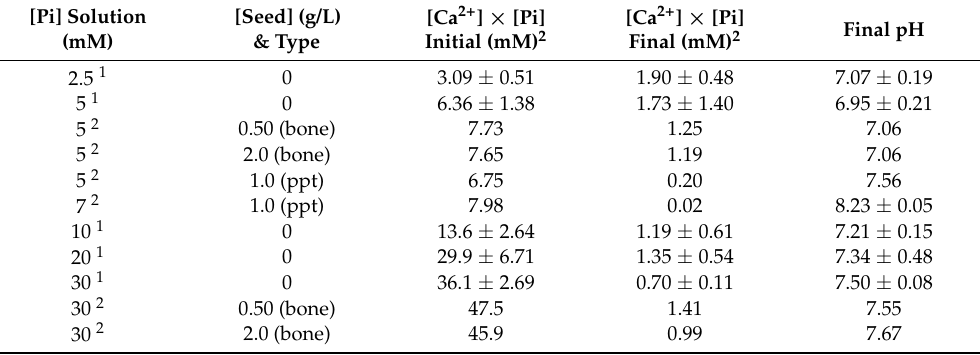
Table 8. Measured [Ca 2+ ] × [Pi] values before and after batch precipitation experiments.